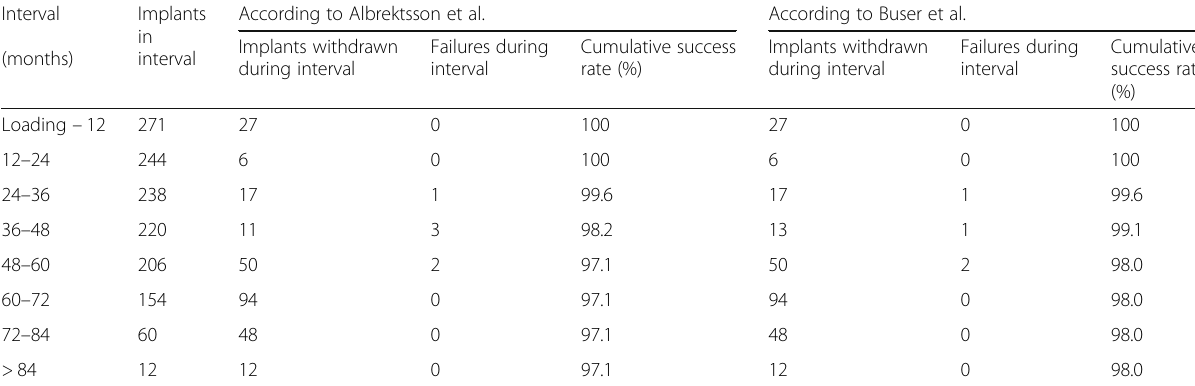
Table 4 Life table analysis showing the cumulative success rate according to Albrektsson et al. and Buser et al. Interval